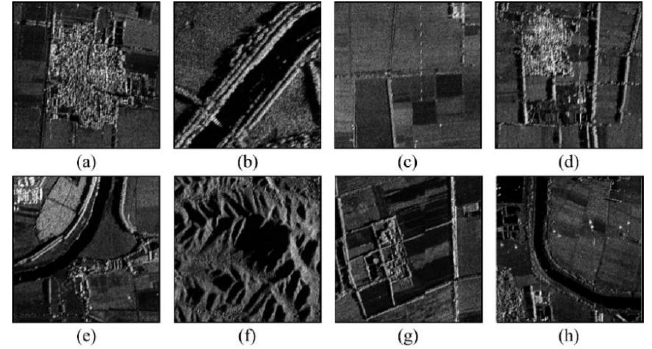
Figure 7. Eight selected SAR Images of Bedfordshire. ( a ) Village, ( b ) river, ( c ) field, ( d ) village, ( e ) river, ( f ) hill, ( g ) village, ( h ) river.